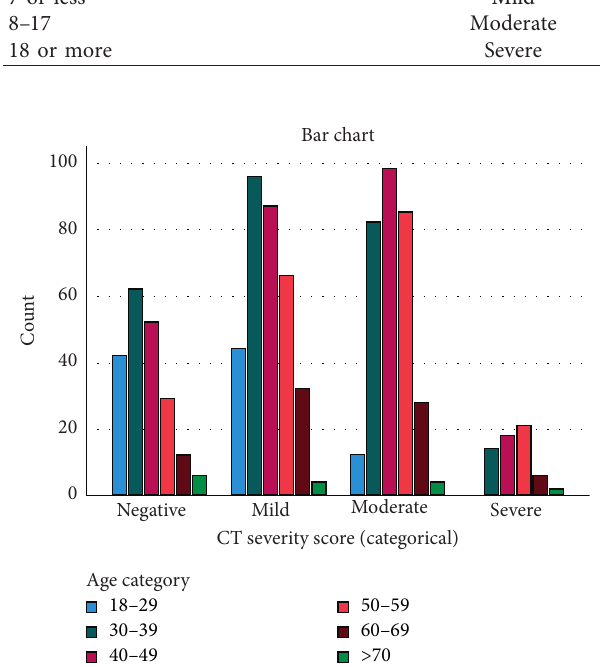
Figure 2: Prevalence of age categories for each CT severity